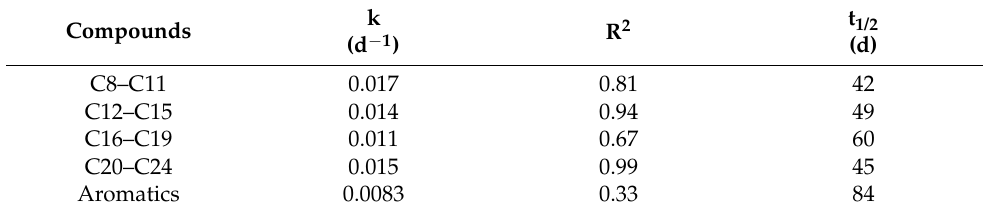
Figure 5. First-order model. Relative standard deviation range: 2.79—14.95%. Table 4. First-order reaction rate constants and half-life times.